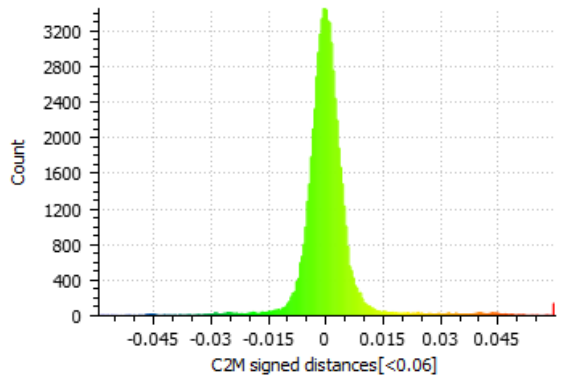
Figure 15: Histogram showing the distances (in meter) between point cloud and modelled